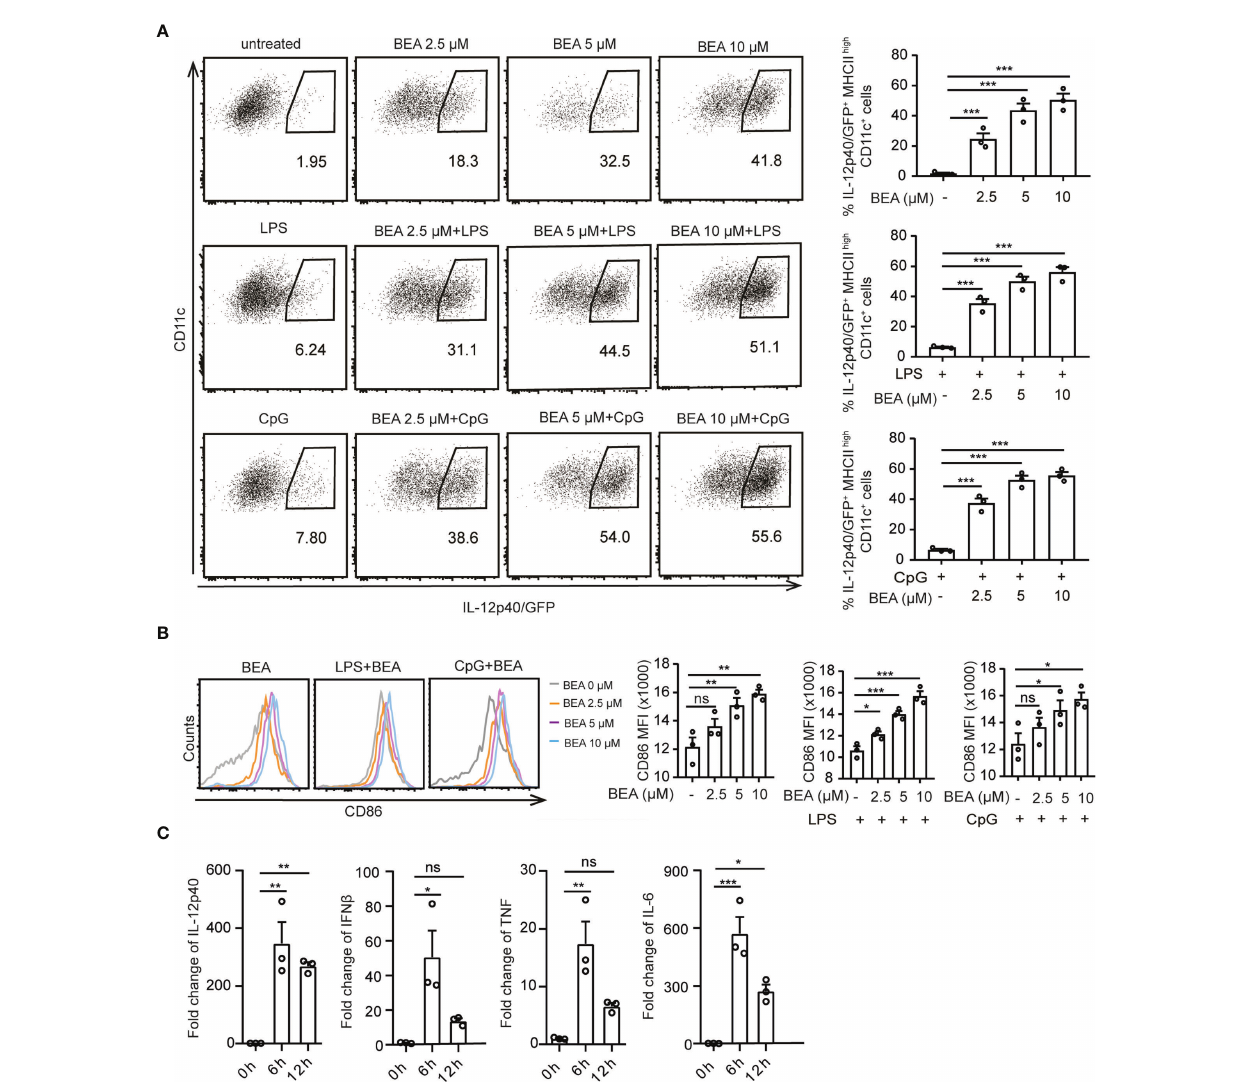
FIGURE 1 | Effects of BEA on BMDCs. (A, B) 5x10 5 BMDCs from IL-12p40/GFP reporter mice were stimulated with indicated concentration of BEA with or without LPS (1 ng/ml) and CpG2216 (0.5 m M) for 16 hours. IL-12p40/GFP (A) and MFI of CD86 expression (B) by BMDCs were detected by fl ow cytometry. Analysis of IL- 12p40/GFP and CD86 expression were gated on MHC II high CD11c + cells. Results shown are representative of three independent experiments using cells from 3 mice per group (n=3). (C) 10 6 BMDCs were stimulated with 5 m M BEA for the indicated time. IL-12p40, IFN b , TNF and IL-6 were analyzed by Real time PCR. Results shown are representative of two independent experiments using cells from 3 mice per group (n=3). Data in A, B and C are presented as mean ± SEM and analyzed by one-way ANOVA with Dunnett ’ s multiple comparisons test. *p<0.05, **p<0.01, ***p<0.001, ns, not signi fi